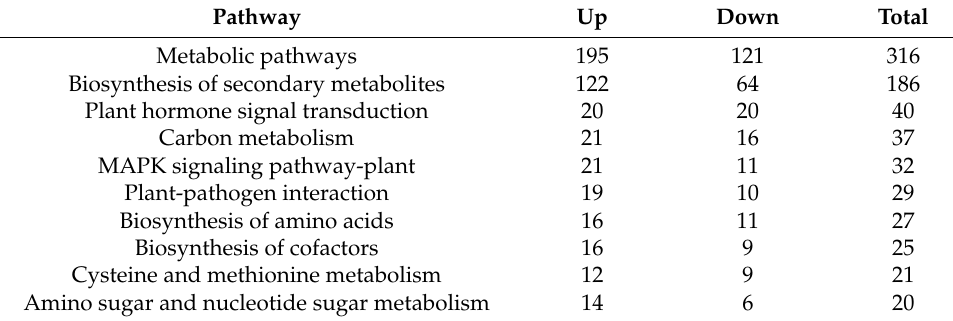
Table 3. Top 10 pathways enriched in the “H 2 O7d vs. H 2 O7d + FOL1h” group.